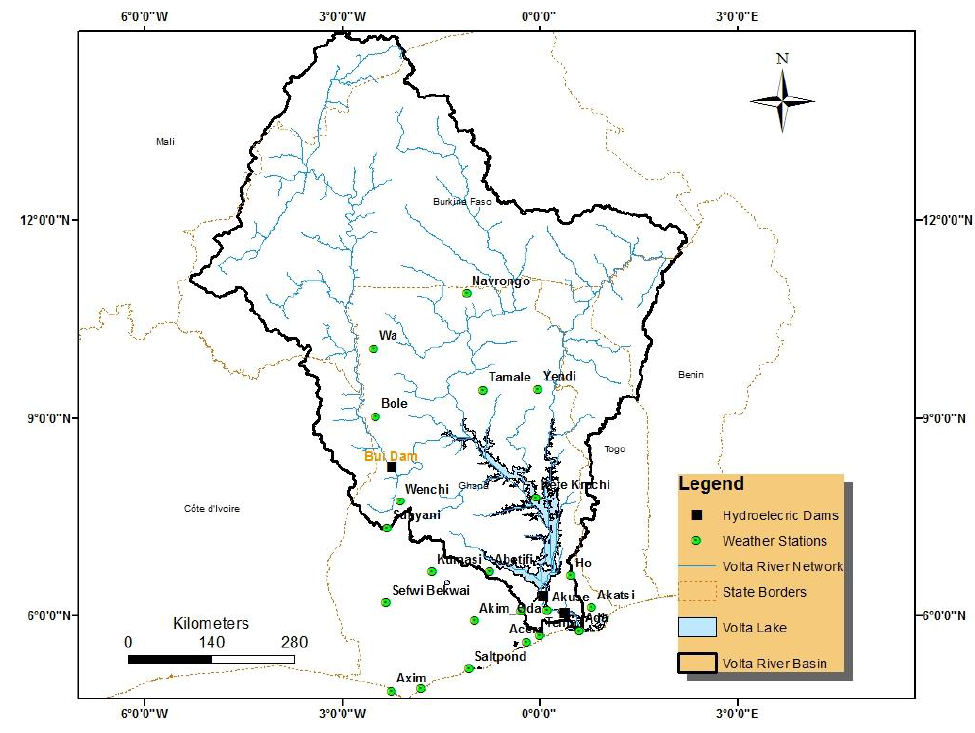
Figure 1. Location of the weather stations in Ghana. Table 1. Data quality control.